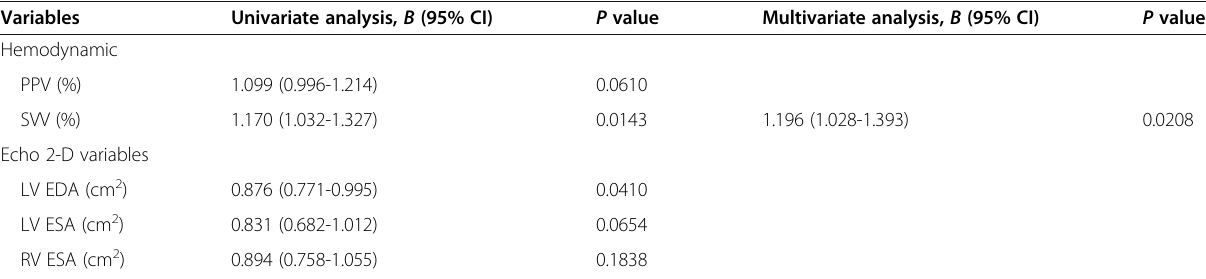
Table 3 Hemodynamic, two-dimensional, pulsed wave, and tissue Doppler echocardiographic parameters associated with fluids responsiveness